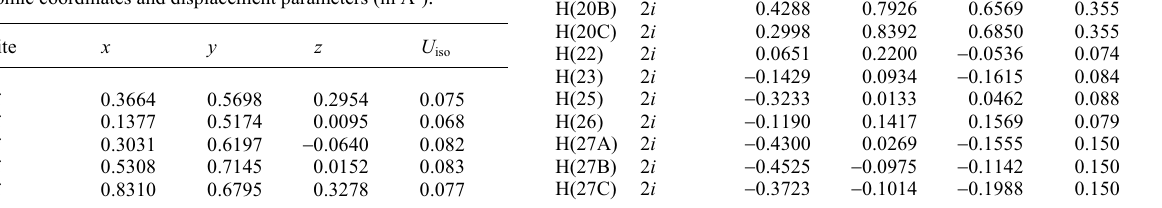
Table 2. Atomic coordinates and displacement parameters (in Å 2 ) .